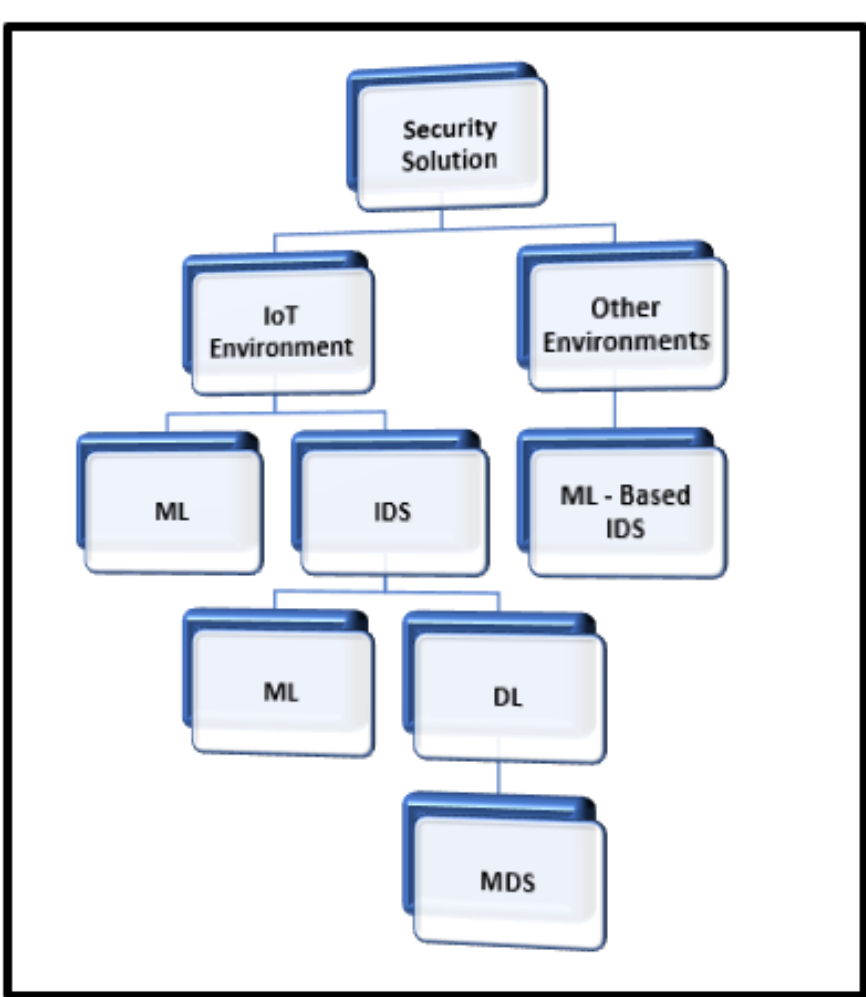
Figure 6. The structure of the paper.